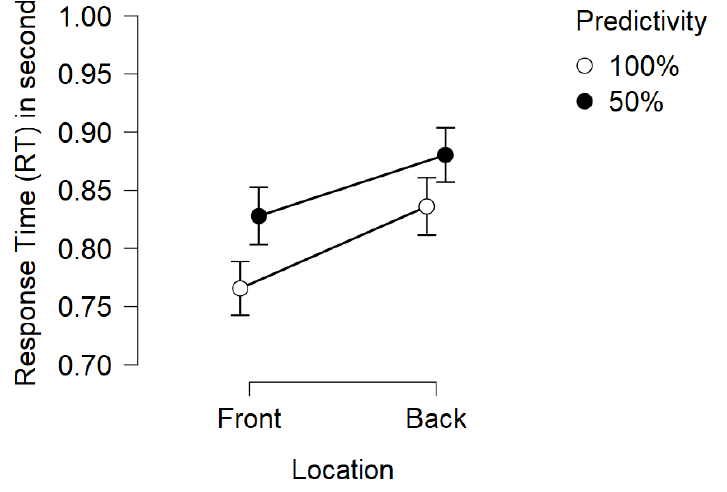
Figure 4. Mean RTs for Ammunition-Choice in response to visual cue according to predictivity and cue-target location. Bars represent standard